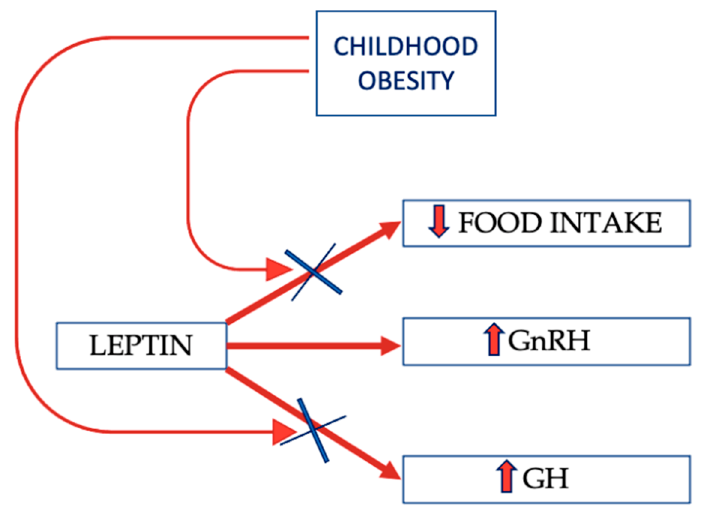
Figure 1. Physiological leptin effects on hypothalamic–pituitary axis; selective resistance can ensue in obesity, blocking some of them (see text). GH: growth hormone; GnRH: gonadotropin-releasing hormone.